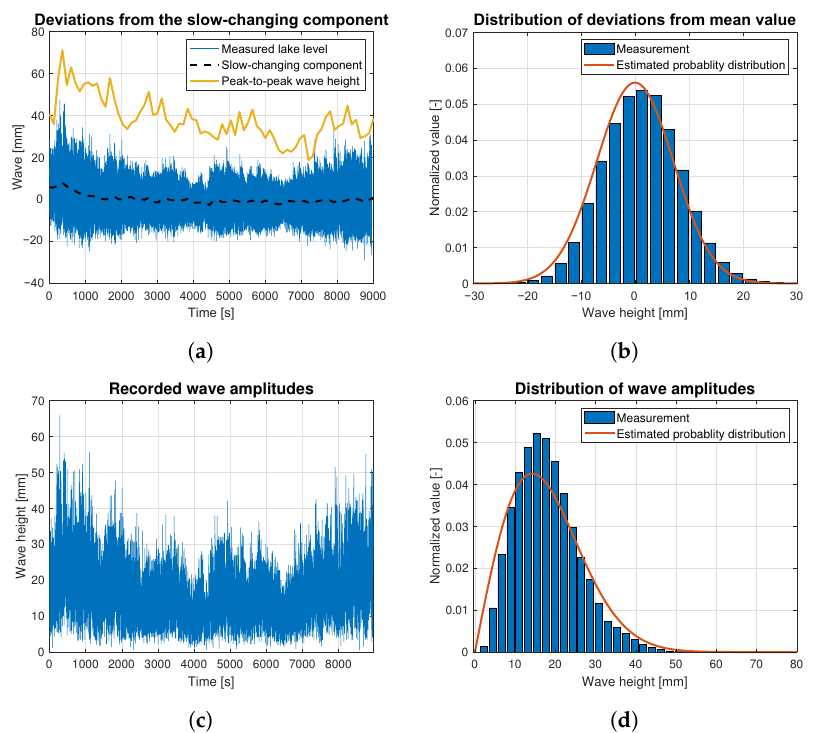
Figure 13. Statistical analysis of the wave height corresponding to 7 BFT wind force in ship scale: ( a ) deviations from the slow-changing component; ( b ) probability distribution of wave height deviations from mean value; ( c ) recorded wave amplitudes; ( d ) probability distribution of wave height